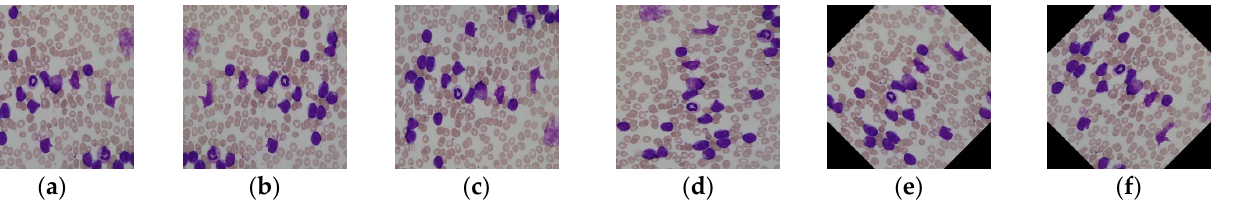
Figure 3. Sample of augmented microscopic blood images; ( a ) original; ( b ) vertically reflected; ( c ) horizontally reflected; ( d ) 90 ° rotated; ( e ) 45 ° rotated; ( f ) − 45 ° rotated.